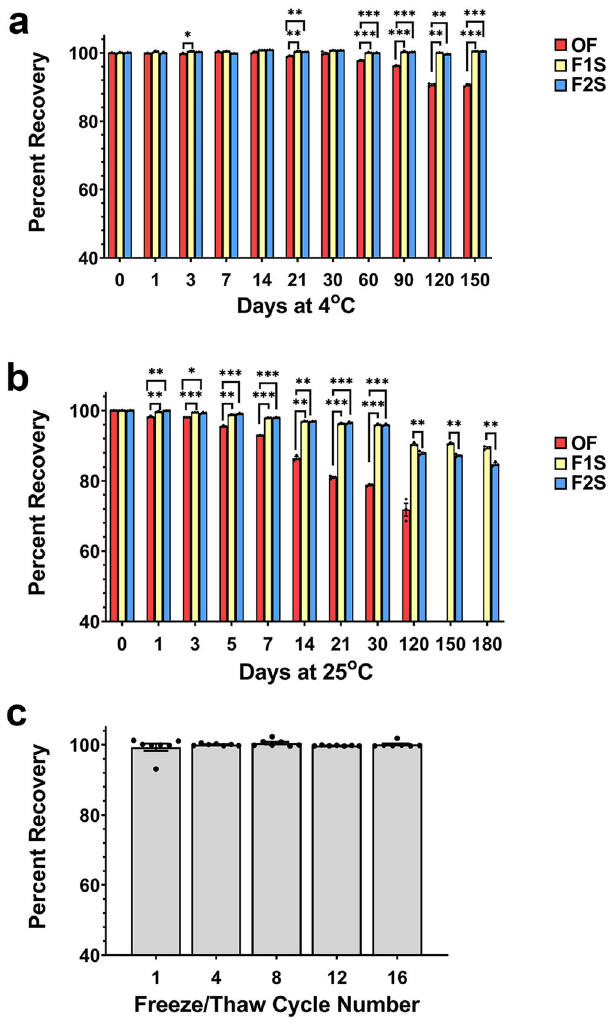
Fig. 5 Optimized fi lm matrices improve AAV stability. Films containing 1 × 10 12 virus genomes were prepared in batch and either stored in controlled environmental chambers held at 4 °C/40 – 50% RH (Panel a ) or 25 °C/60% RH (Panel b ) or subjected to a series of 16 freeze-thaw cycles (Panel c ). Replicates (at least 3 per timepoint) were reconstituted and live AAV concentration was assessed by a standard infectious titer assay. In Panels a and b , the Standard Control Formulation (OF, red bars) consisted of phosphate-buffered saline, 350 mM NaCl, 5% Sorbitol, and 0.001% Pluronic F68 (pH 7.4). In each panel, data represents the average ± the standard error of the mean of three replicates per timepoint or condition. In Panels a and b , signi fi cant differences between the F1S (yellow bars) and F2S (blue bars) formulations with respect to the standard control formulation (OF) were evaluated by two-way ANOVA with Dunnett ’ s post hoc tests * p < 0.05, ** p < 0.01, *** p < 0.001 In Panel b , statistical differences between the F1S and F2S formulations are indicated on data collected from day 120 through 180, ** p < 0.01. For statistical differences of OF vs F1S and OF vs F2S from day 120 through 180, all p values are <0.001 and not shown in Fig.